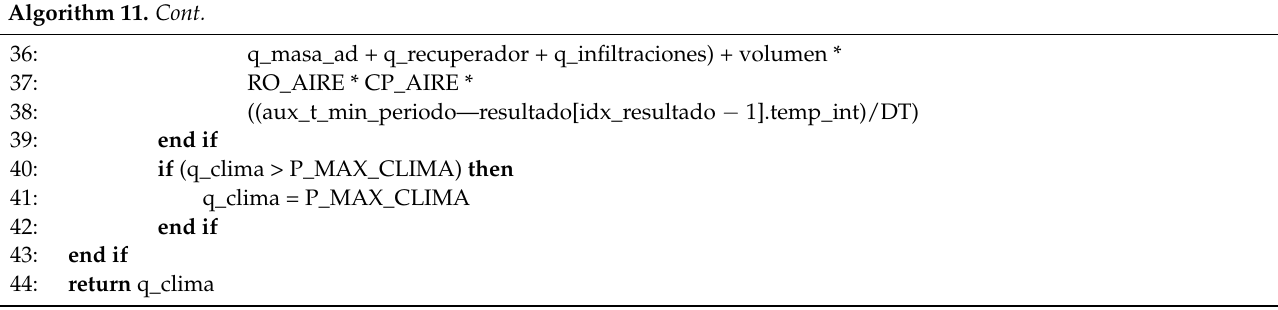
Algorithm 12 groups processes 2.2.23, 2.2.24 and 2.2.25. The first process obtains the total heat of the simulated house, the second calculates the interior temperature of the simulated house, and the third processes the cooling and heating demands of the building. Algorithm 12. Compute interior temperature (2.2.23), Compute total heat (2.2.24) and Compute thermal demands (2.2.25) // Compute total heat (2.2.24)